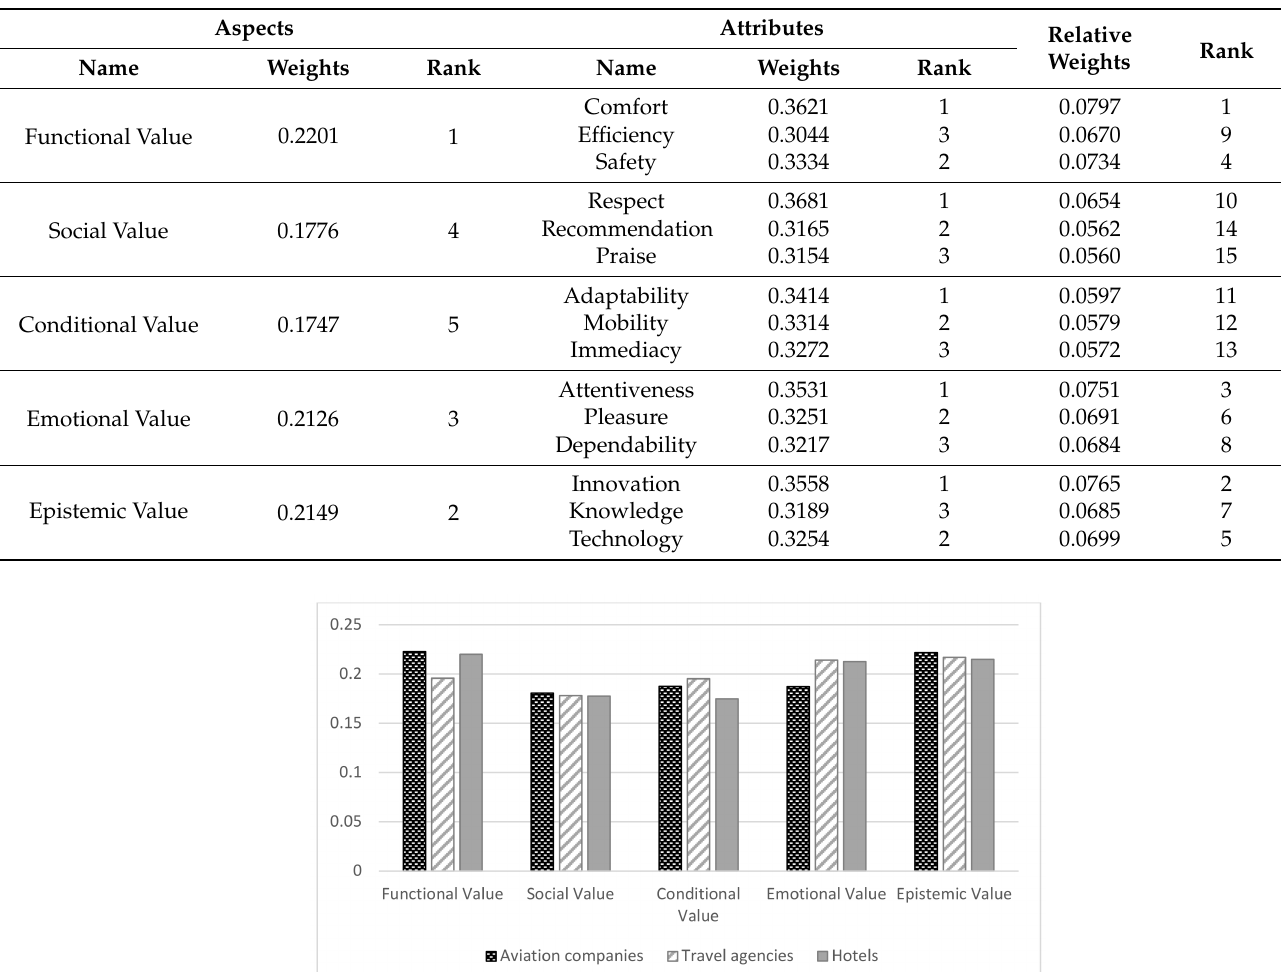
Table 11. Hotels service quality weights.